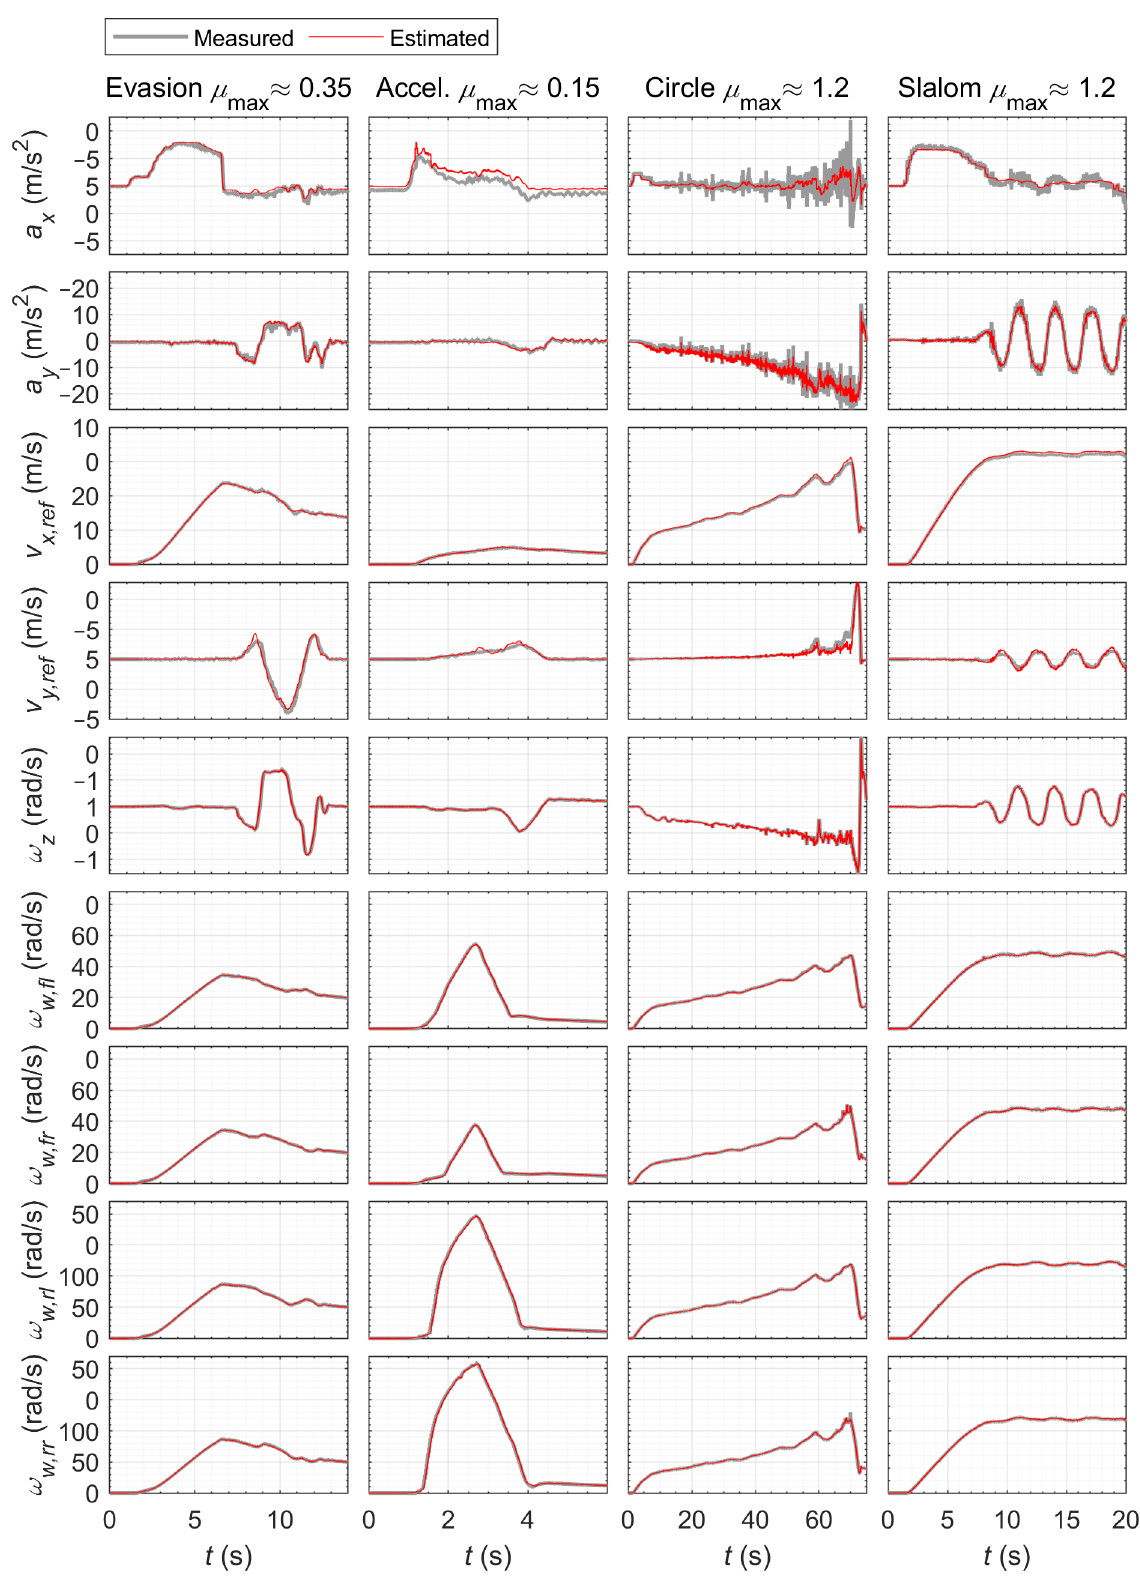
Figure A3. Test data: measured and estimated accelerations, velocities, yaw rate, and wheel